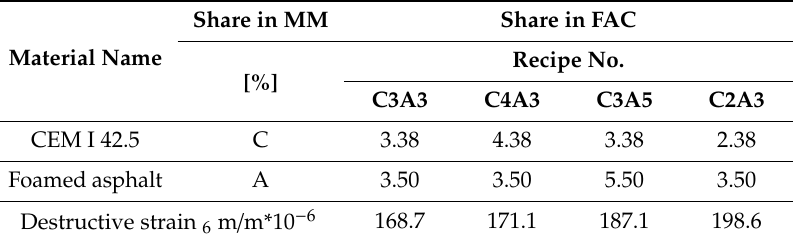
Table 5. Fatigue durability of FAC mixtures.